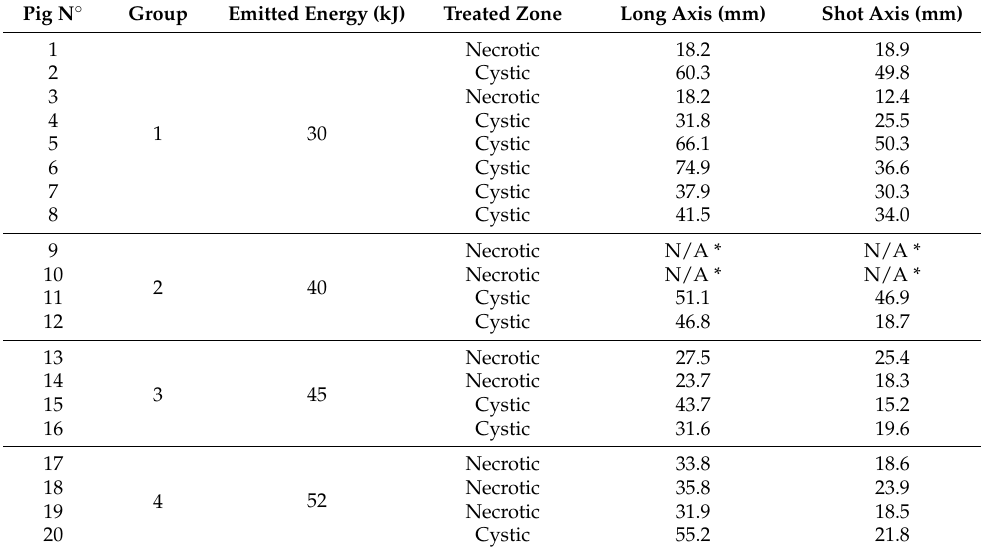
Table 2. Dimensions of the lesions measured macroscopically. * Ablations could not be precisely measured because of fragmentation of pancreatic